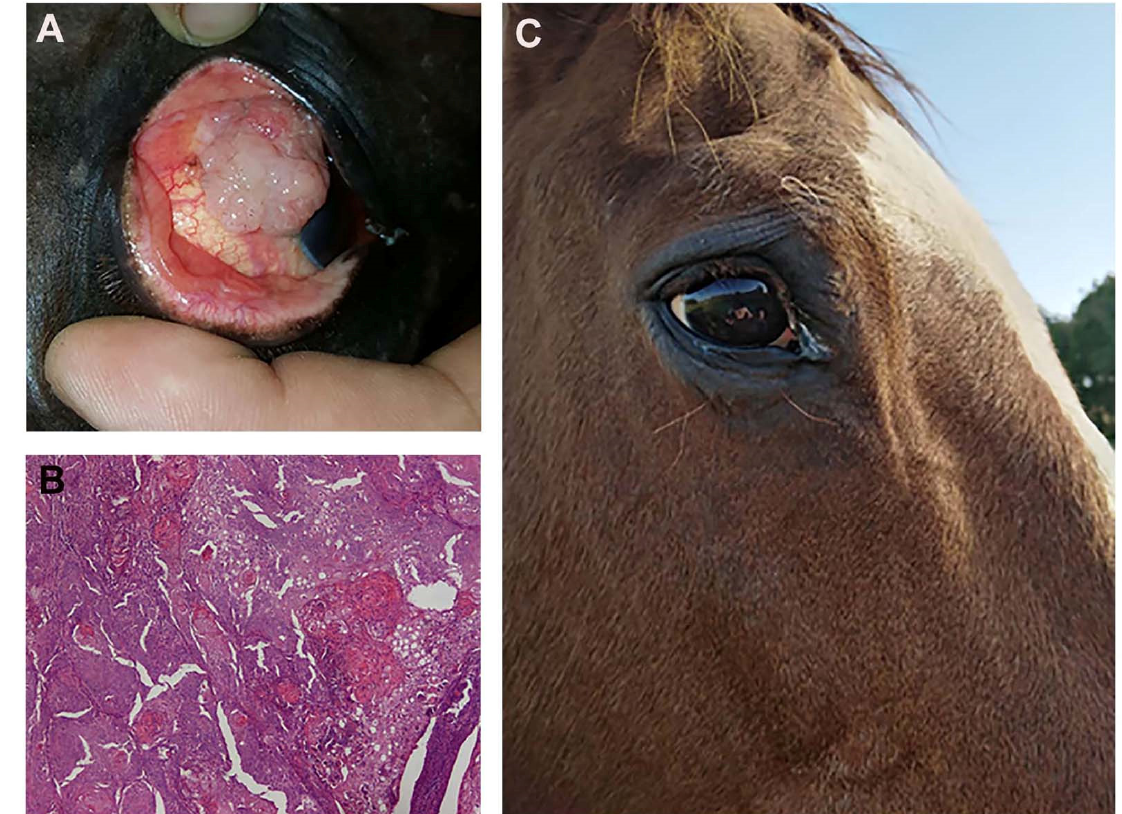
Figure 13. ( A ) a fourteen-year-old saddlehorse with corneal squamous cell carcinoma, resulting in a proliferation that covers most of the corneal surface. ( B ) Histopathology after surgical excision: a high tumor cell mitotic index and the formation of several keratin pearls are visible (Hematoxylin and Eosin staining; original magnification × 20). ( C ) The patient at one year follow up: there is no evidence of recurrence and eye functionality has been fully restored.